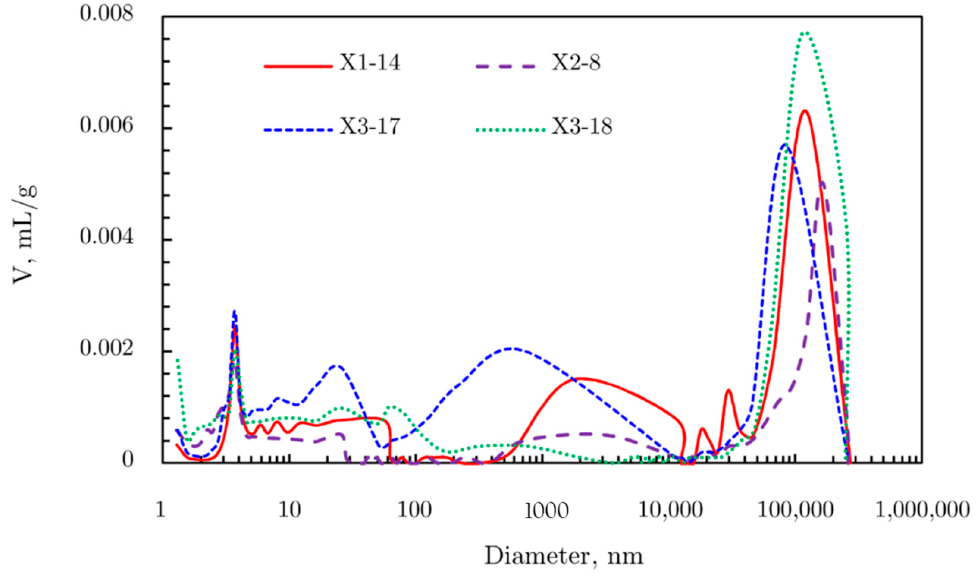
Figure 15. PSD of samples from the Longmaxi Formation based on N 2 adsorption and MICP.